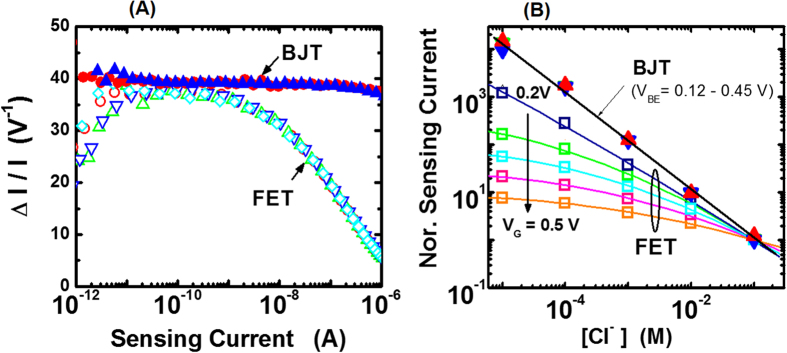
Sensitivity and calibration curves comparison for BJT and FET sensors.(A) BJT sensor sensitivity (ΔIC/IC) comparison with FET sensor sensitivity (ΔID/ID); different colored symbols denote measurements made at different chloride concentrations; filled and open symbols correspond to BJT and FET sensors, respectively. (B) Comparison between normalized calibration curves for BJT and FET sensors; normalization is done by dividing the measured sensing current at different [Cl−] by the sensing current measured at 100 mM KCl solution; each curve is measured at a fixed applied voltage VBE or VG values as indicated by different colored symbols; solid lines are fits to data; normalized calibration curves for the BJT sensor are independent of the applied voltage VBE value, whereas FET curves depend on the applied voltage VG.